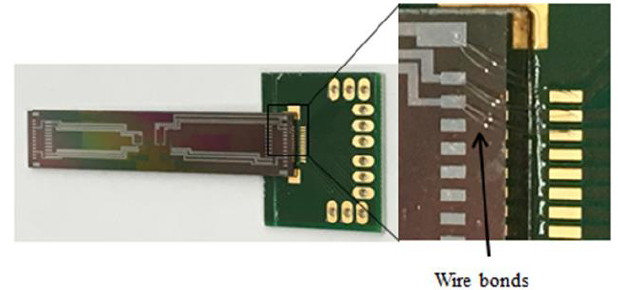
Figure 7. Contact pads of the meander wires bonded to a PCB.